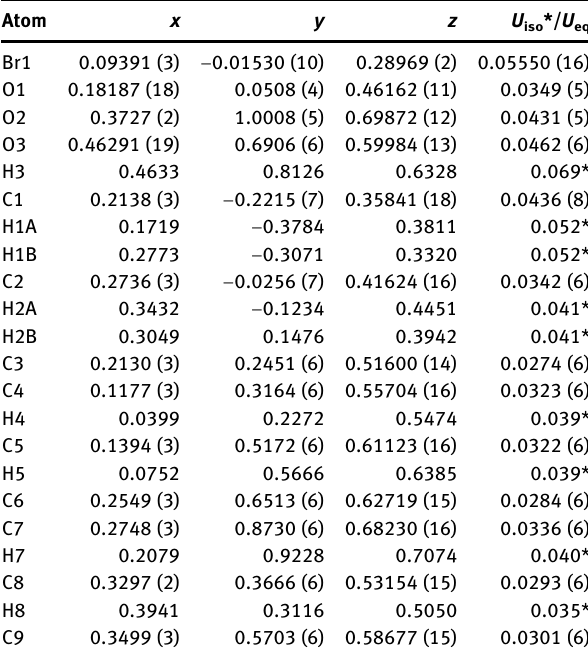
Table  : Fractional atomic coordinates and isotropic or equivalent isotropic displacement parameters (Å 